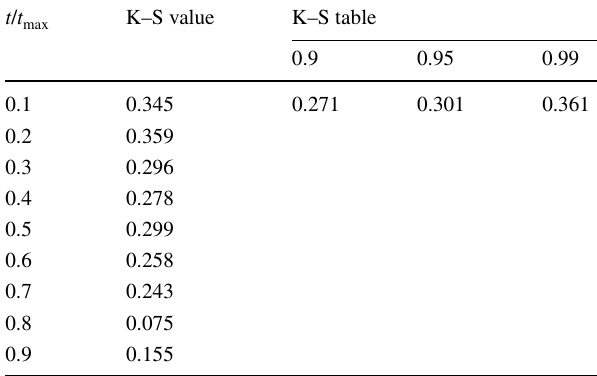
t / t max ) at various ( max